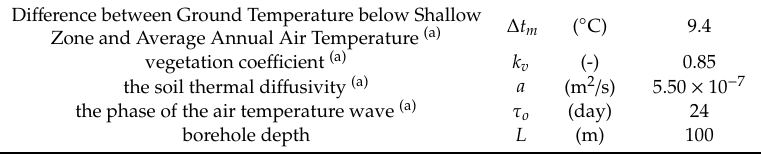
Table 3. Data for mean ground temperature determination.